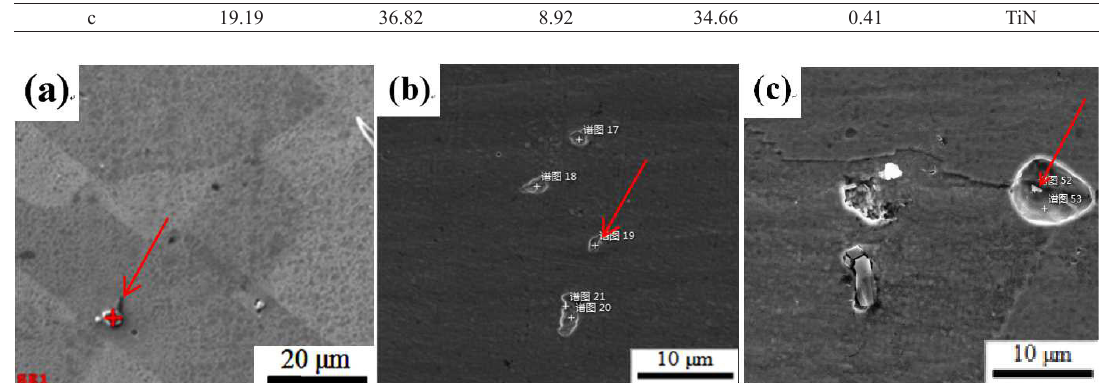
Figure 13. The precipitated phases in wire-filled PAWjoint (a) TiN (b) TiC (c) TiN.